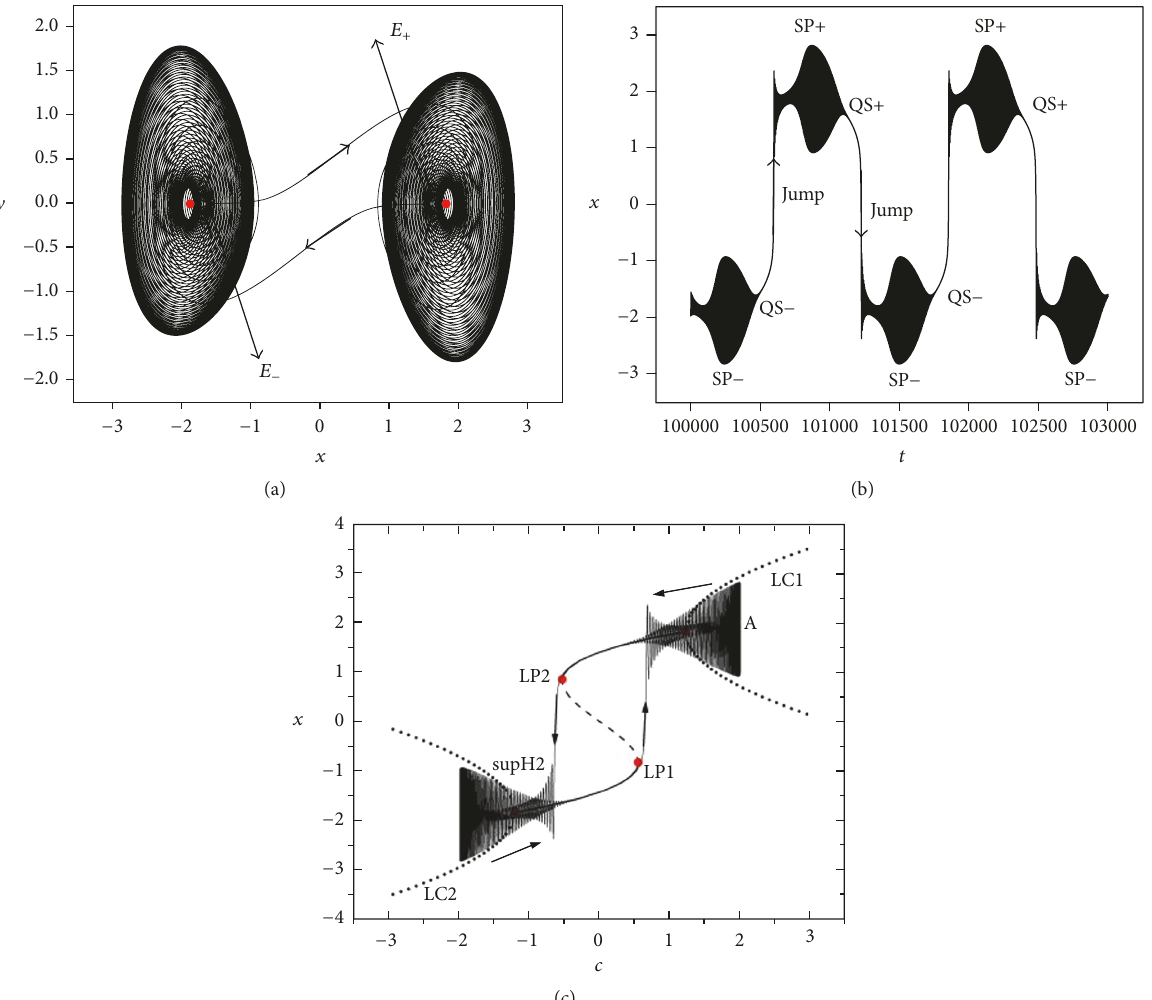
Figure 7: Bursting oscillation for 𝐴 = 2 . (a) Phase portrait on the (𝑥,𝑦) plane; (b) time history; (c) overlap of the transformed phase portrait on the (𝑐,𝑥) plane with the system bifurcation